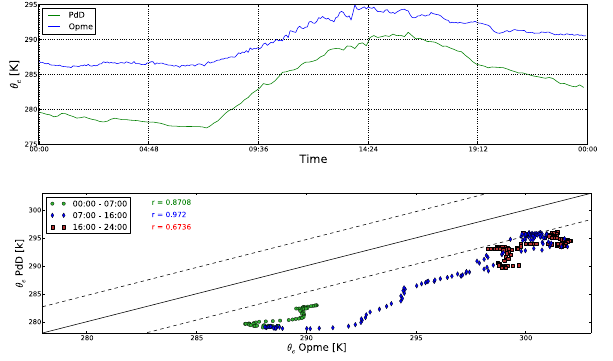
Fig. 12. Left panel: LIDAR z 2 -signal evolution in arbitrary units in case of simultaneous nucleation event (22 March 2009). Right panel: average LIDAR z 2 -signal i- before 09:00 (green line), ii- between 09:00 and 11:00 (nucleation time) and iii- after 11:00. On both graphics, the black dot line represents the hight of the puy de Dˆome